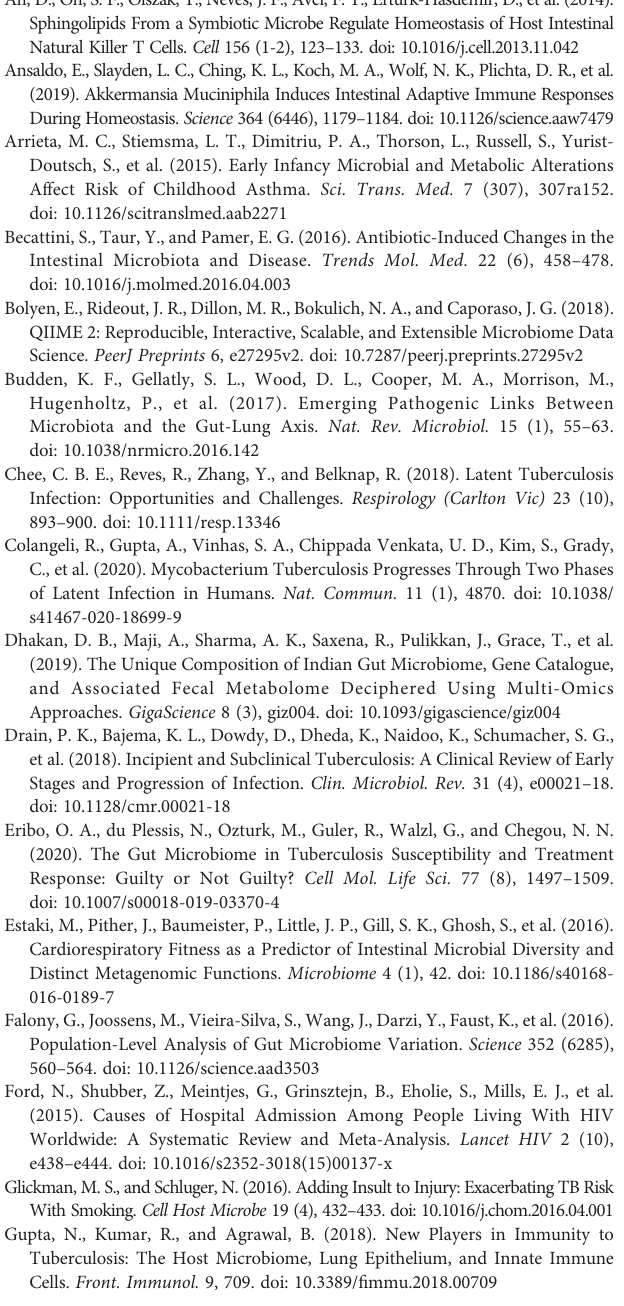
Supplementary Table 2 | Species taxonomic annotation at different levels. Supplementary Table 3 | Results of the ROC curve analyses of signi fi cant species in training and testing sets. Supplementary Figure 1 | The rarefaction curves of the three groups. Supplementary Figure 2 | Fourspecieswithdifferencesinthetoptenatphylumlevel.